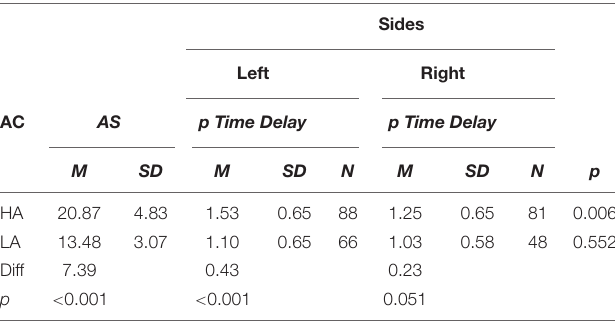
Sides Left Right